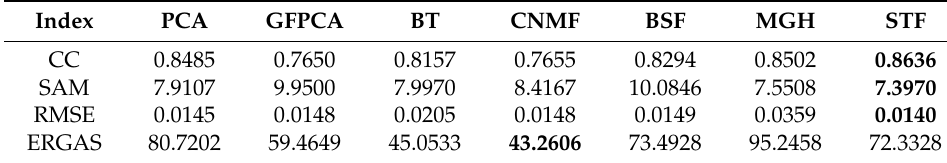
Table 4. Quantitative results of different fusion methods for Washington DC dataset.